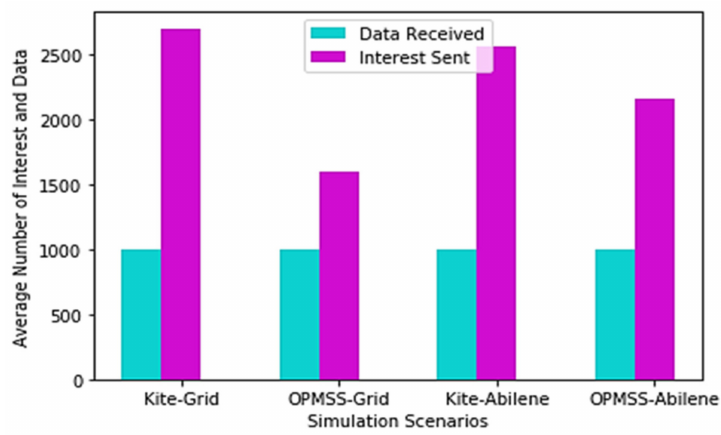
Figure 9. Interest packet loss in different